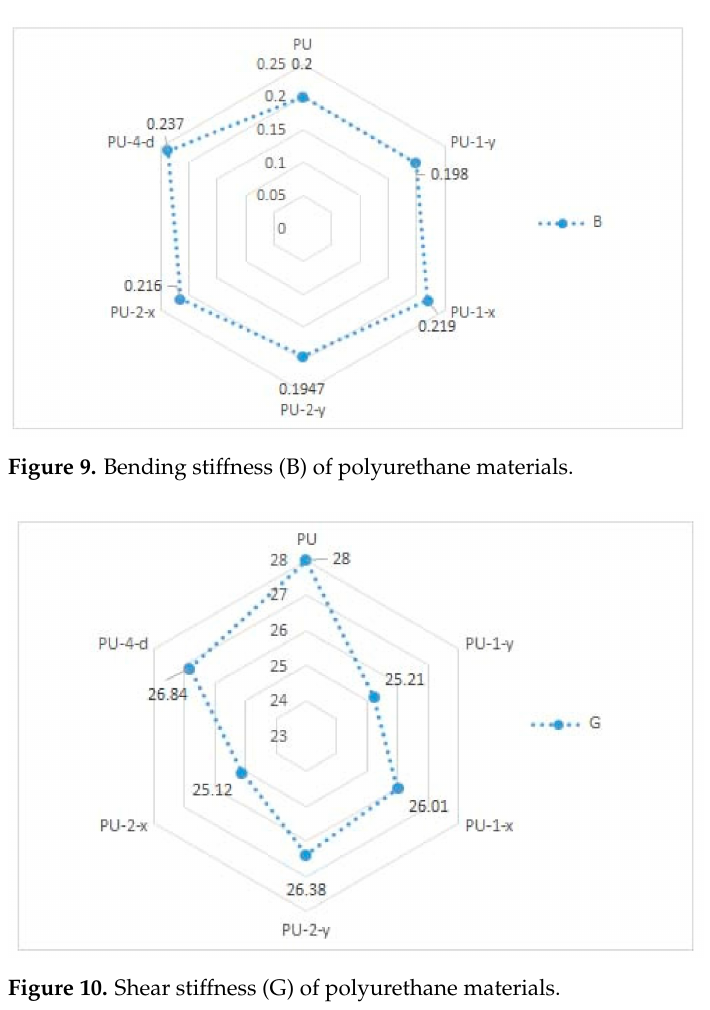
Figure 10. Shear stiffness (G) of polyurethane